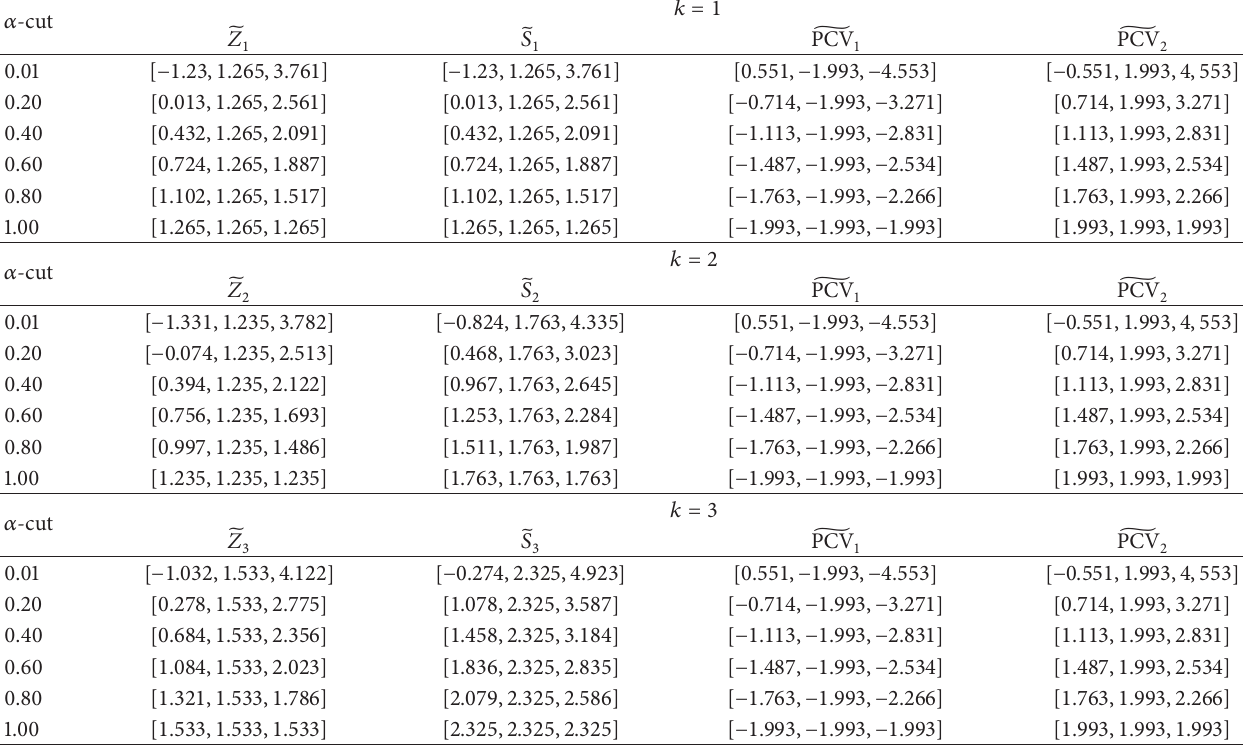
Table 4: Base and peak values {[𝑎 1 , 𝑎 2 ,𝑎 3 ]} of triangular shaped fuzzy numbers for group sequential test using 𝛼 -cuts for 𝐾 = 3 and 𝑘 = 1, 2, 3 . 𝛼